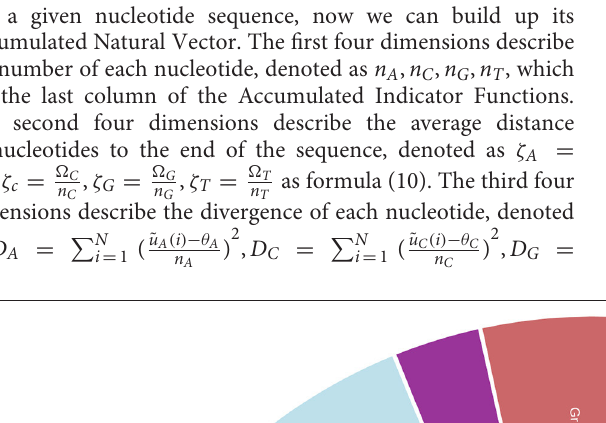
Frontiers in Genetics |